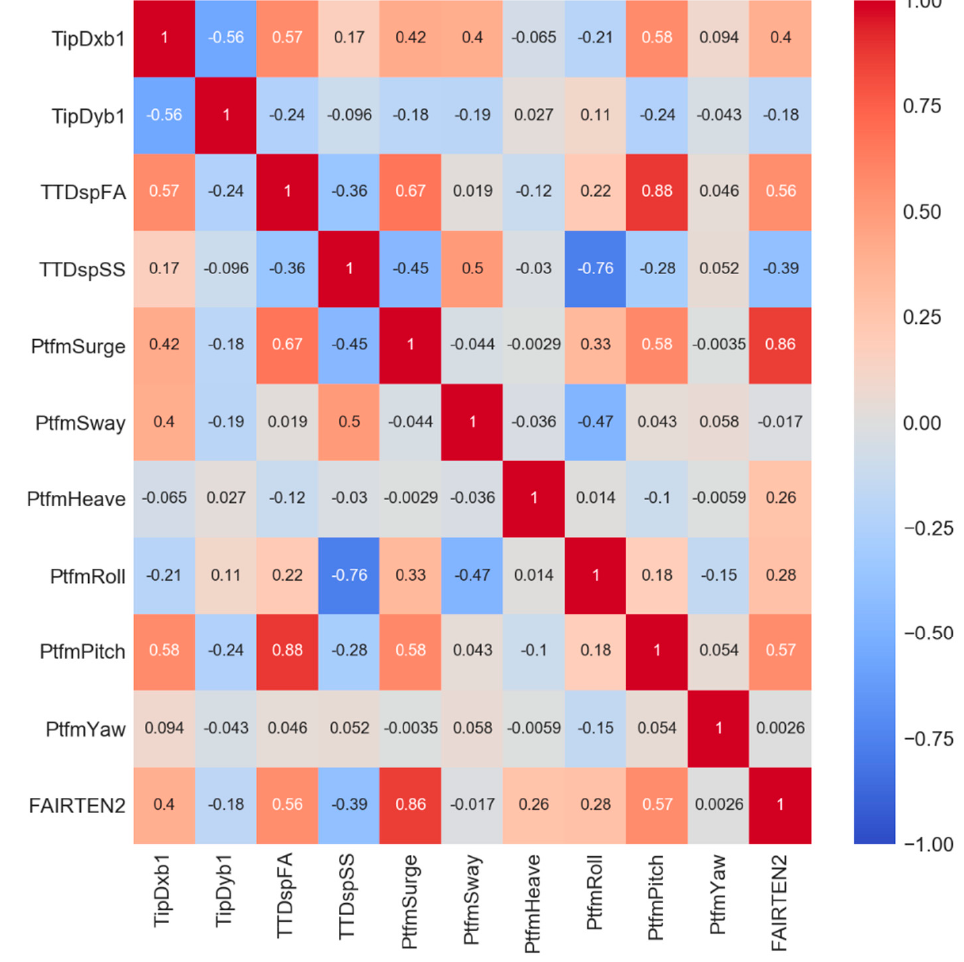
Figure 11. Heat map (slack mooring line).